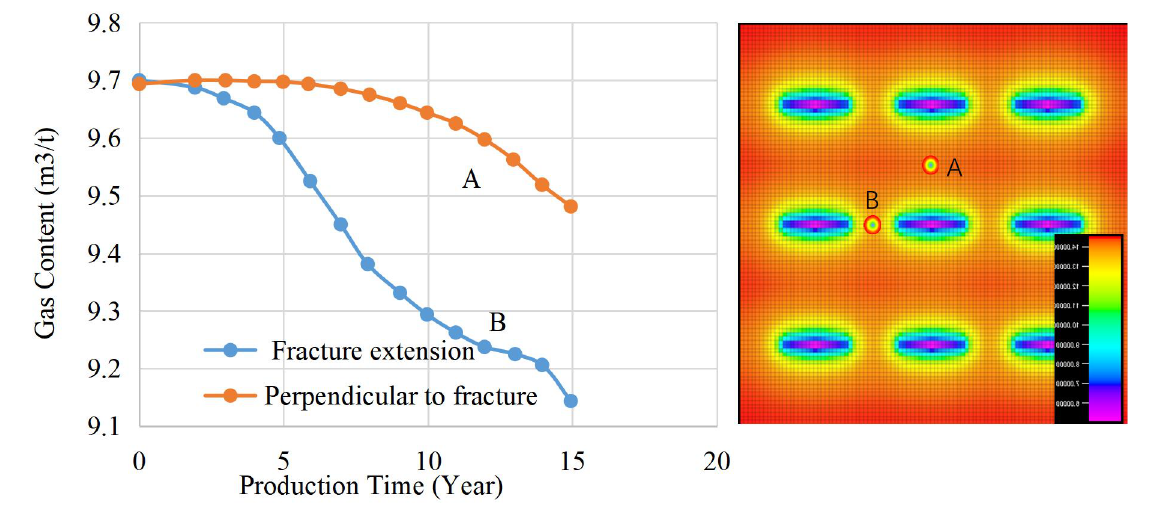
Figure 5—Gas content change along fracture extension direction and perpendicular to fracture in 8#